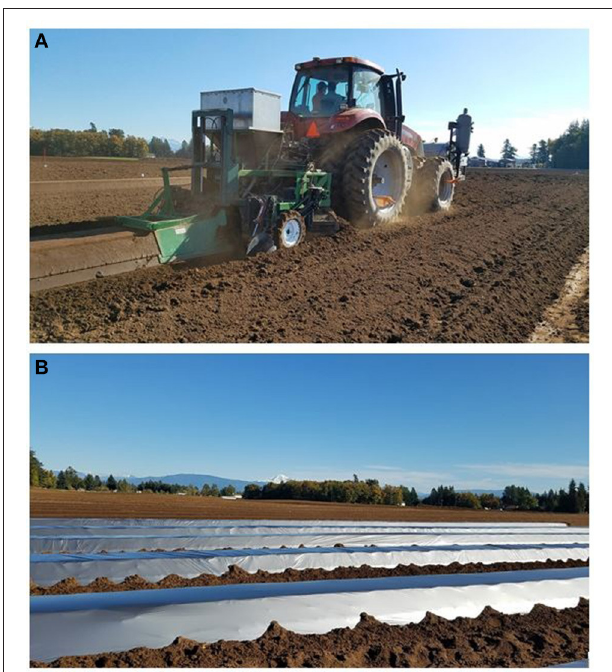
FIGURE 2 | (A) Pre-plant soil fumigation. (B) Tarps applied after soil fumigation to reduce emissions and improve fumigant retention in the soil (photos by Lisa W. DeVetter).